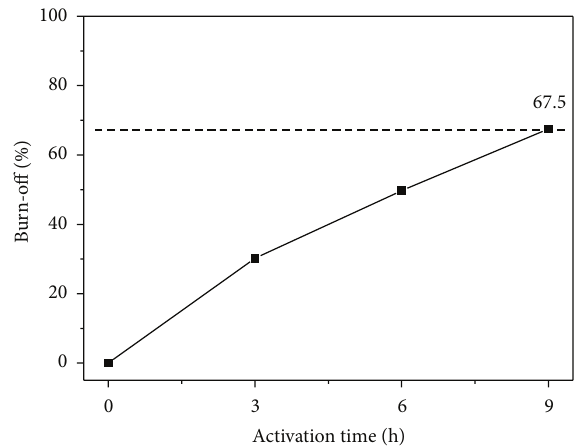
Figure 1: Evolution of burn-off versus activation time for carbon spheres treated in CO 2